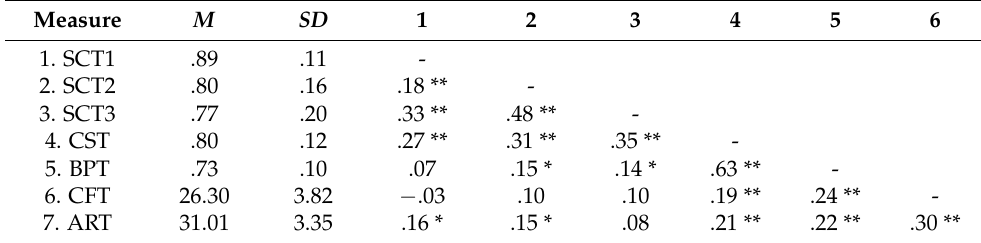
Table 1. Descriptive statistics for all measures and the intercorrelations between them ( N = 215).